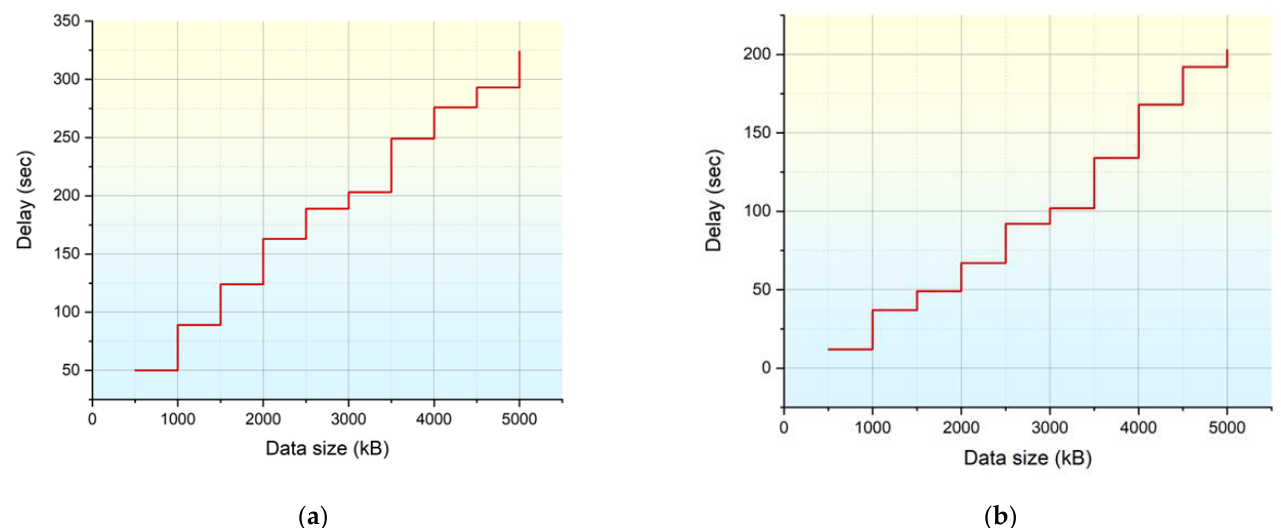
Figure 6. ( a ) Delay analysis of the existing CPS model and ( b ) delay analysis of the proposed IWMCPS model.